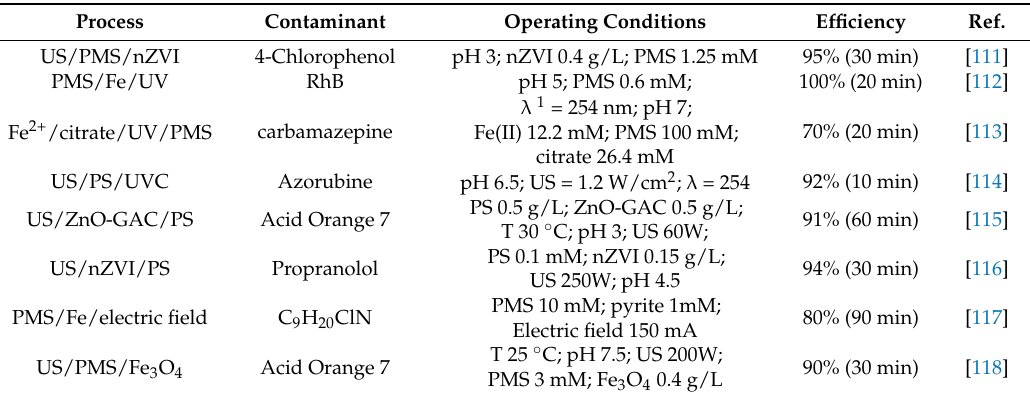
Table 7. Hybrid technology for PS and PMS